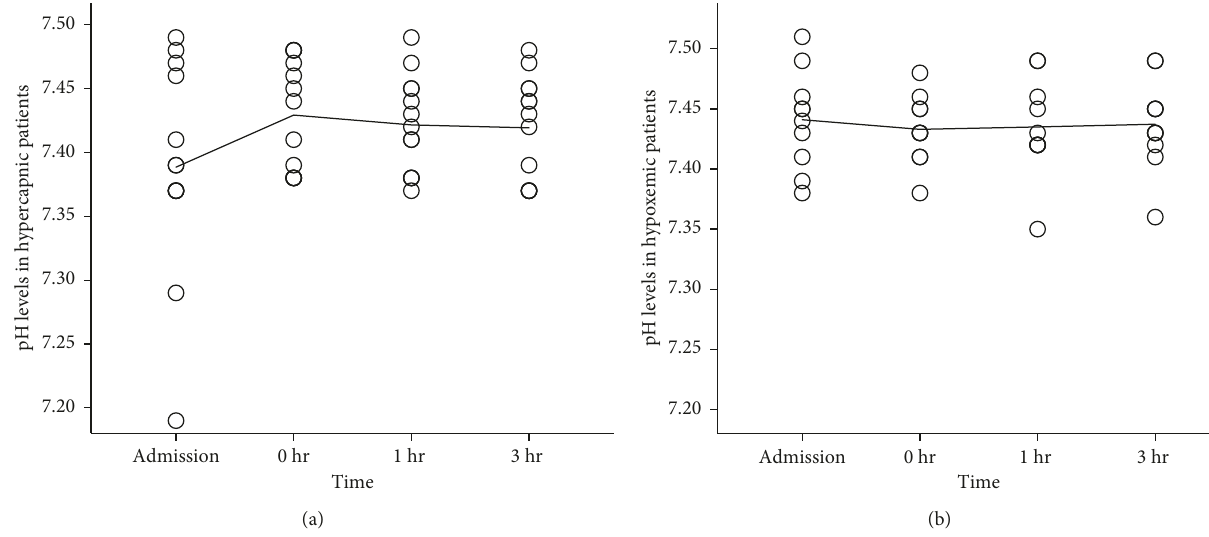
Figure 3: pH levels of hypercapnic and purely hypoxemic ARF patients at admission, just before the application of the device (0hr), 1 hour after the application of the device (1hr), and 3hours after the application of the device (3hr). The line corresponds to the mean value of each group.